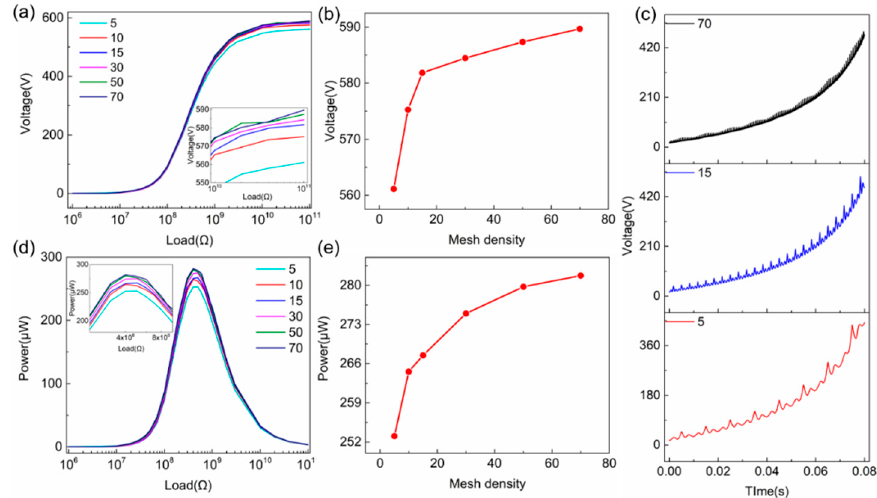
Figure 6. The simulated ( a ) voltage and ( d ) power output with increasing mesh density. ( b ) The summarized peak voltage at a 100-G Ω external load with increasing mesh density. ( e ) The summarized peak power output with increasing mesh density. ( c ) The voltage curve under different mesh density.